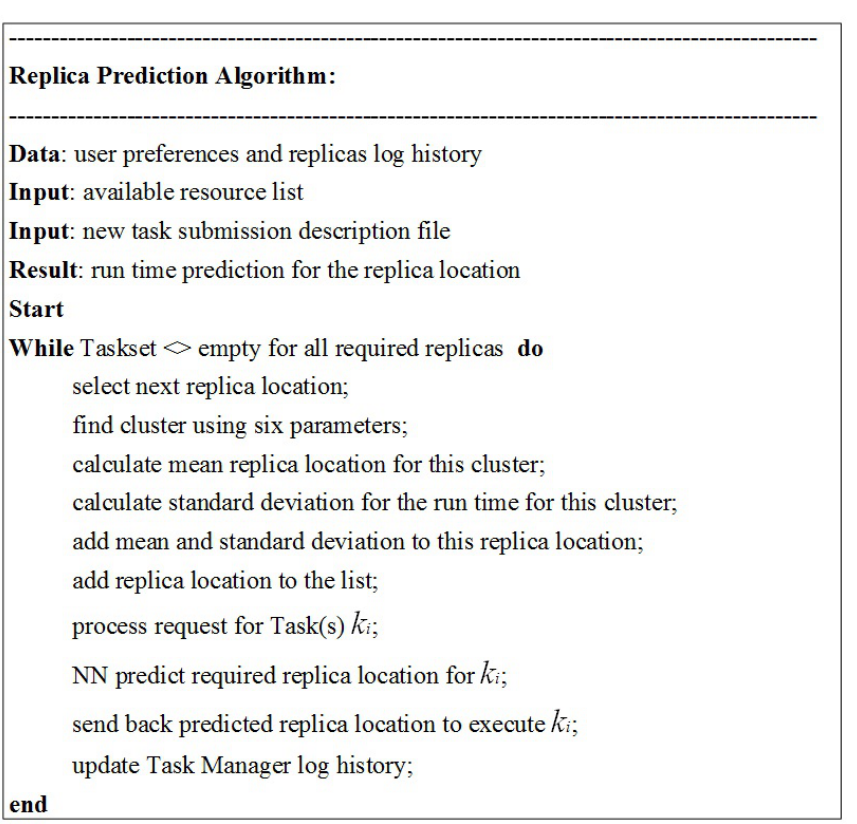
Figure 5. Replica location prediction